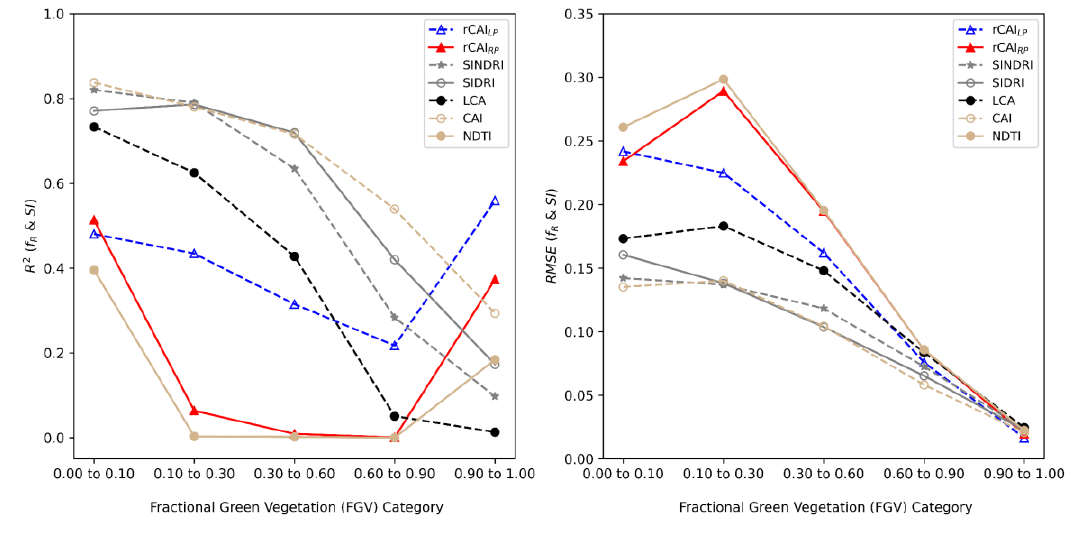
Figure 11. Heritage spectral index (SI) f R estimation performance according to f GV (FGV) class. Left panel is R 2 and right panel is RMSE .